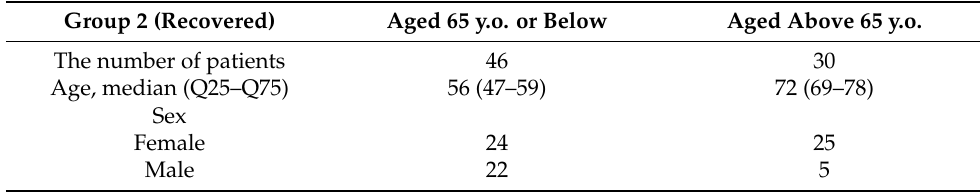
Table 19. Demographic data in Group 2 patients with